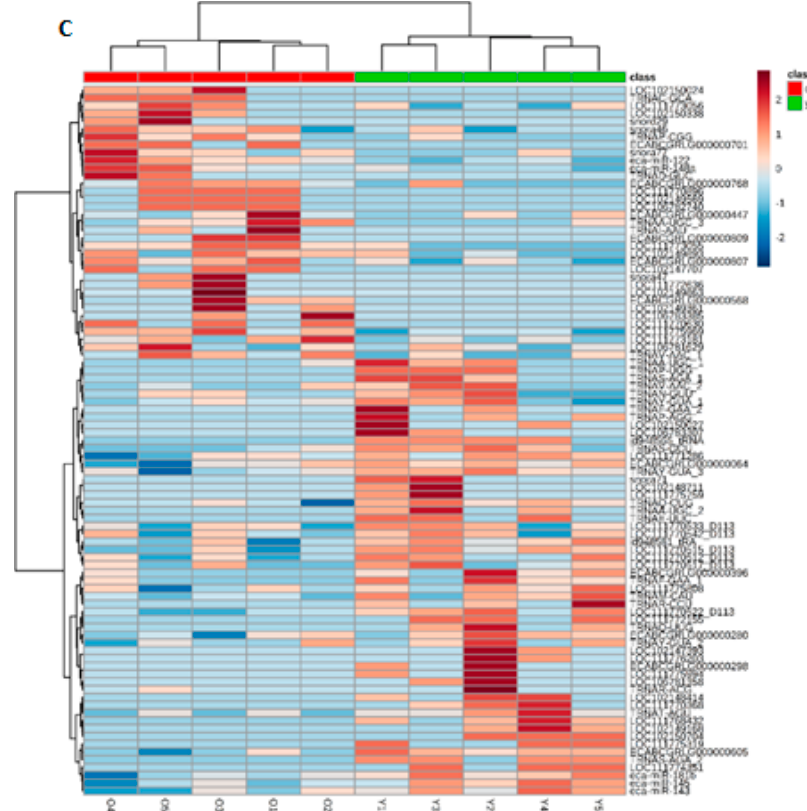
Figure 1. Age-related differential small non-coding RNA (sncRNA) gene expression. ( A ) The categories of non-coding RNAs identified in young and old equine chondrocytes; long non-coding RNAs (lncRNAs), microRNAs (miRNAs or miRs), small nucleolar RNAs (snoRNAs), small nuclear RNAs (snRNAs), transfer RNAs (tRNAs). ( B ) 3D principle component analysis (PCA) plot between the selected principle components (PCs). The explained variances are shown in brackets. ( C ). Clustering results shown as a heatmap (distance measure using Euclidean, and clustering algorithm using Ward) for the top 90